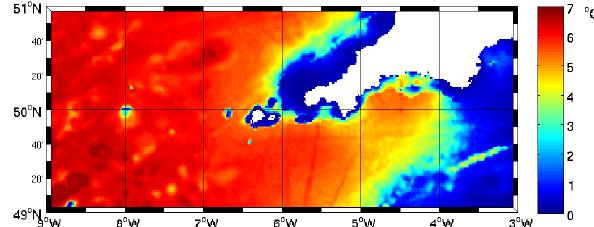
Figure 11. Surface–bottom temperature differences ( ◦ C) across the southern Celtic Sea and western English Channel, in mid-July of 2014, simulated with S2P3-R configured in twelve 1 ◦ × 1 ◦ sub- domains, as